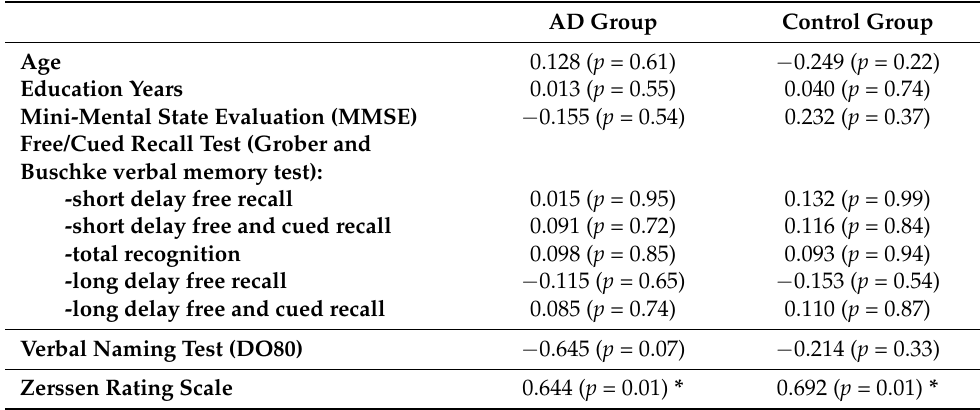
Table 3. Correlations of Shalling Sifneos Psychosomatic Scale (SSPS-R) scores with cognitive and mood variables in the AD and control groups.